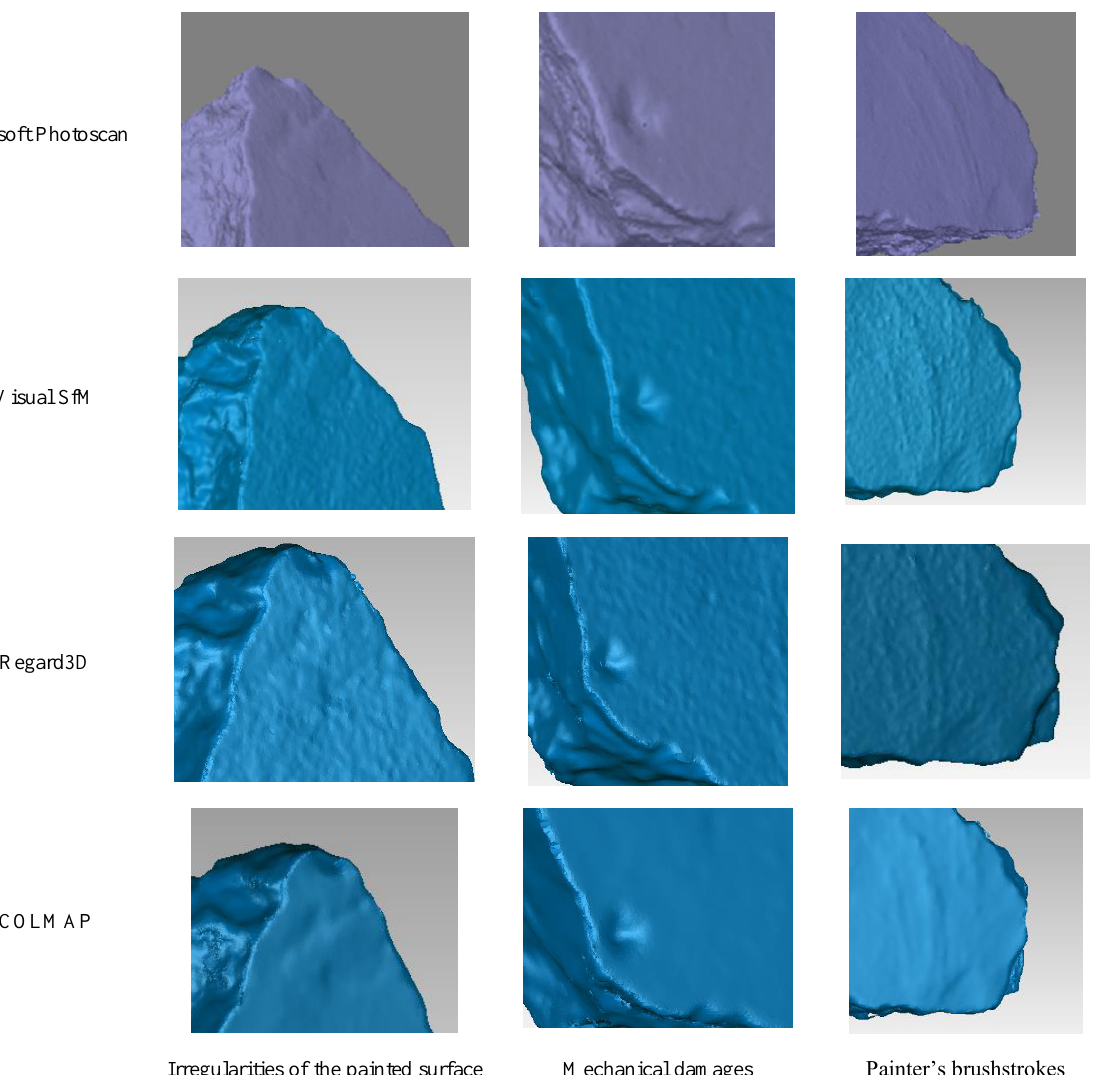
Figure 11: Different cases that a conservator can study applied in 3d models created via commercial and open source